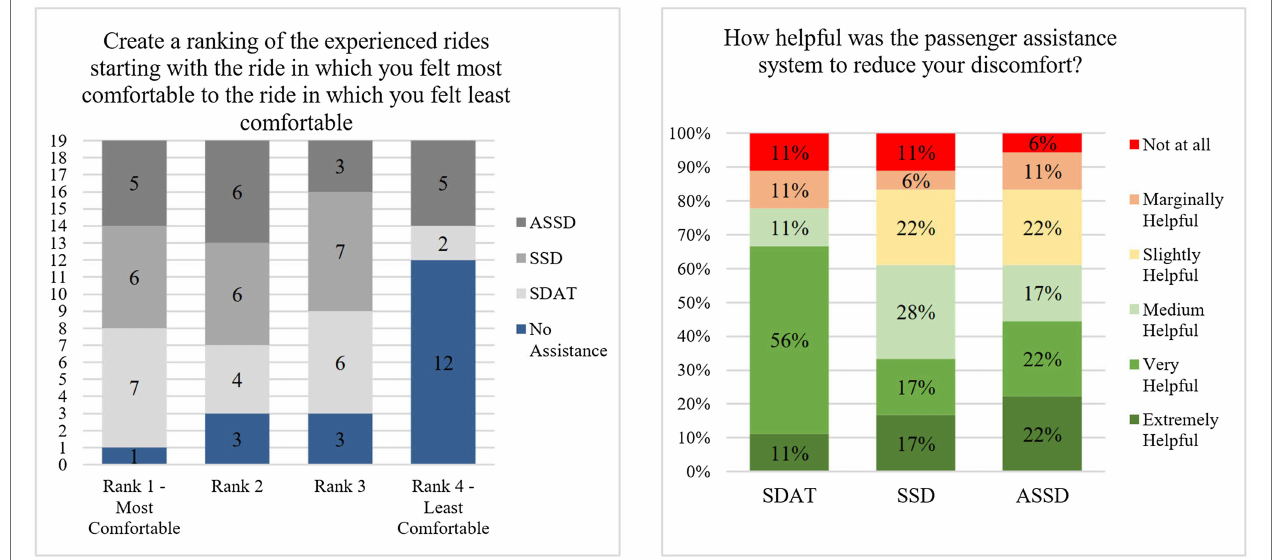
FIGURE 8 | Left: Ranking of the assistance system rides from most to least comfortable. Right: Helpfulness ratings for the different assistance systems made in the post inquiry.